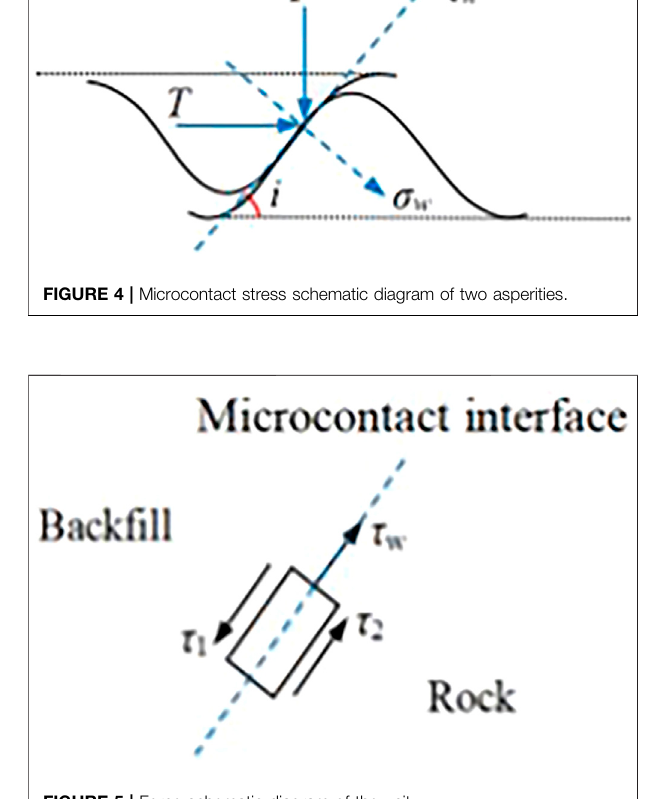
FIGURE 5 | Force schematic diagram of the